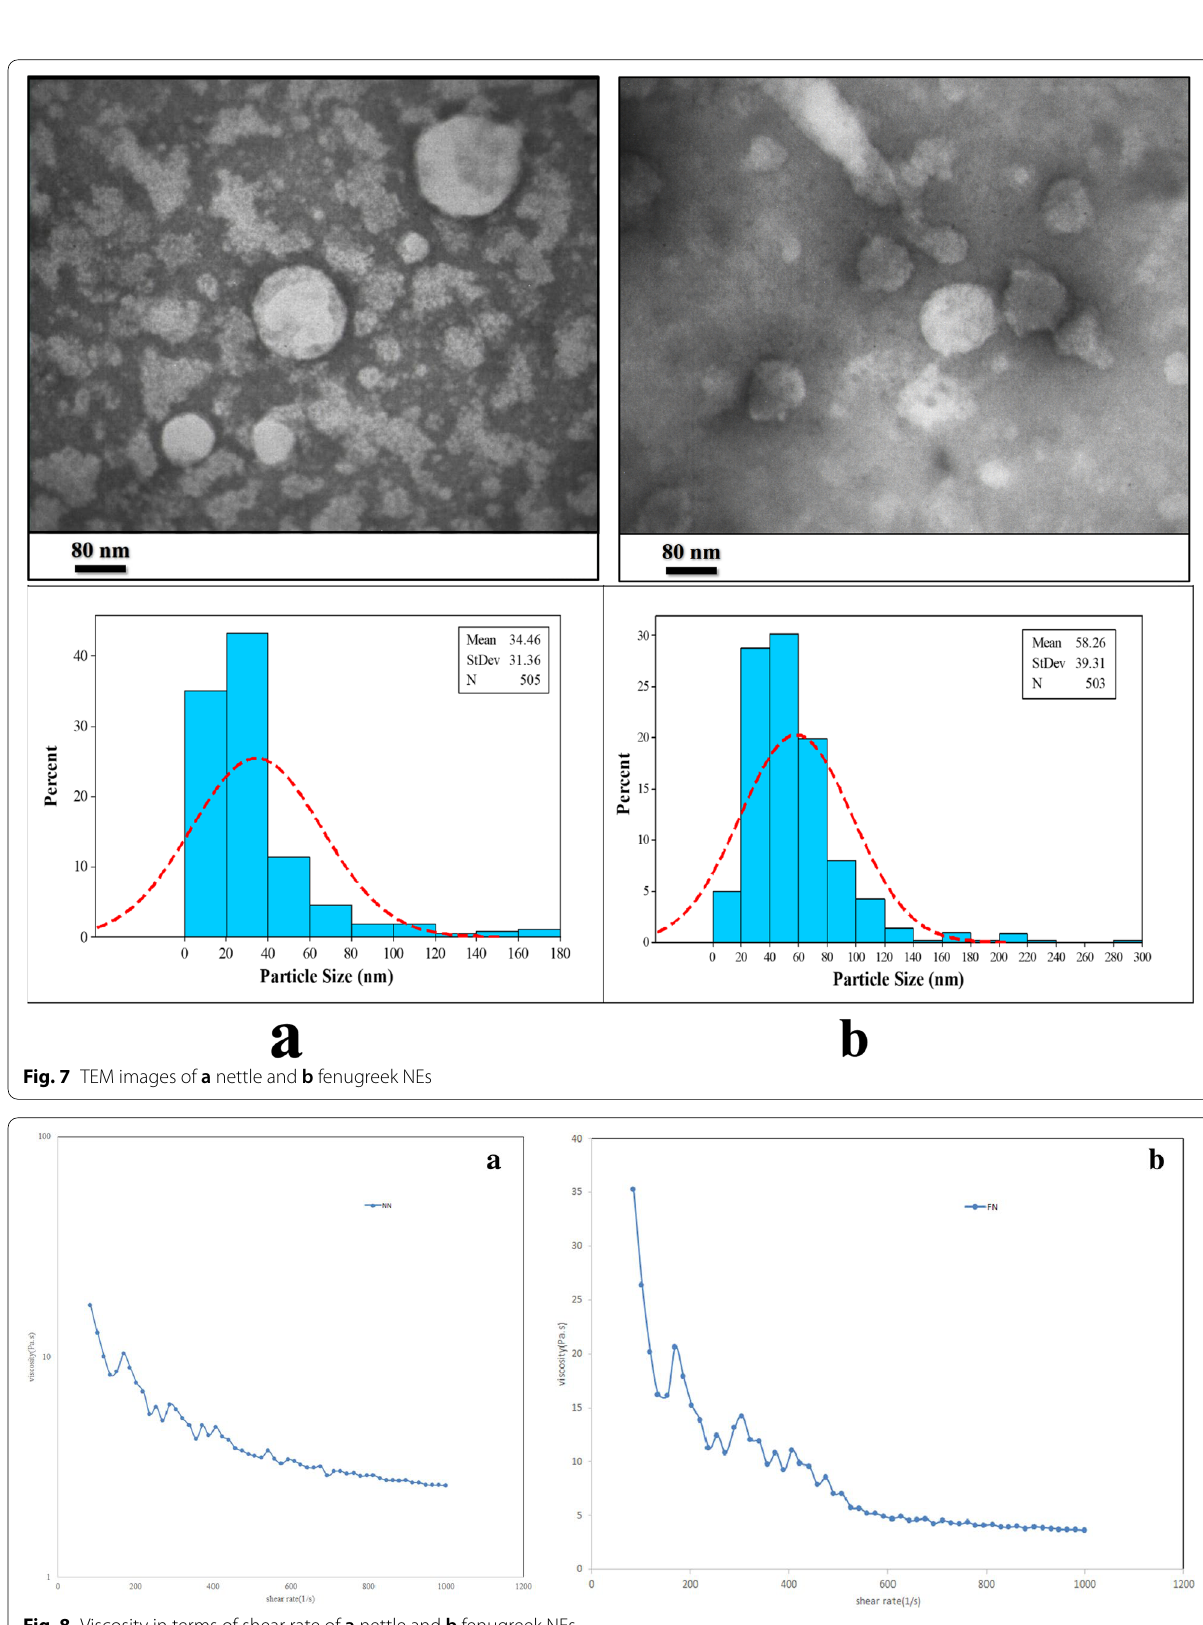
Fig. 8 Viscosity in terms of shear rate of a nettle and b fenugreek